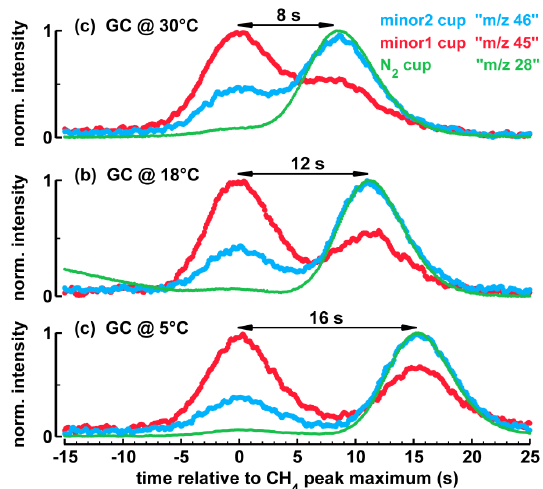
Fig. 8. Chromatograms showing the separation between CH 4 (left peak) and Kr (right peak) on a PoraPLOT column for 30°C, 18°C and 5°C measured with the Bern system. The Kr interference is visible in all Faraday cups, either as a direct signal of 84 Kr 3+ in the m/z 28 cup (thin green line), or from the broad Kr interference for the minor1 and minor2 (thick red and blue, respectively).